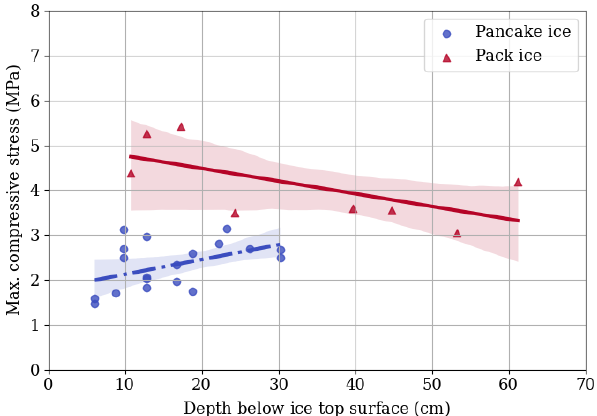
Figure 17. Uniaxial compressive strength for pancake ice and con- solidated ice against brine volume as compared to the relation found by Kovacs (1997) using the strain rate of 5 × 10 − 4 s − 1 applied to obtain the data reported